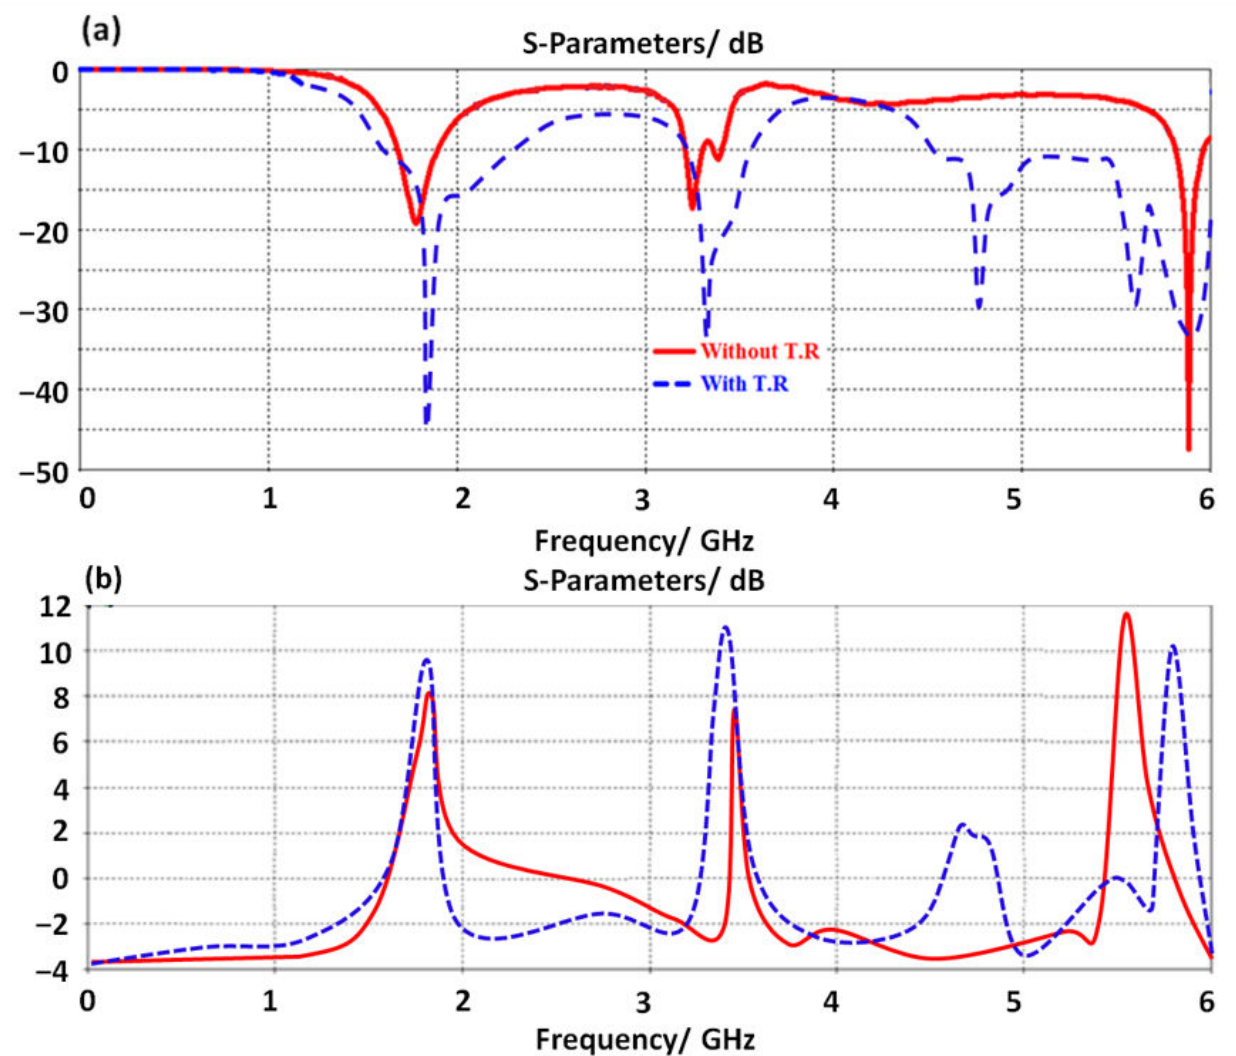
Figure 4. Antenna performance with and without TR structure: ( a ) S 11 spectra and ( b )